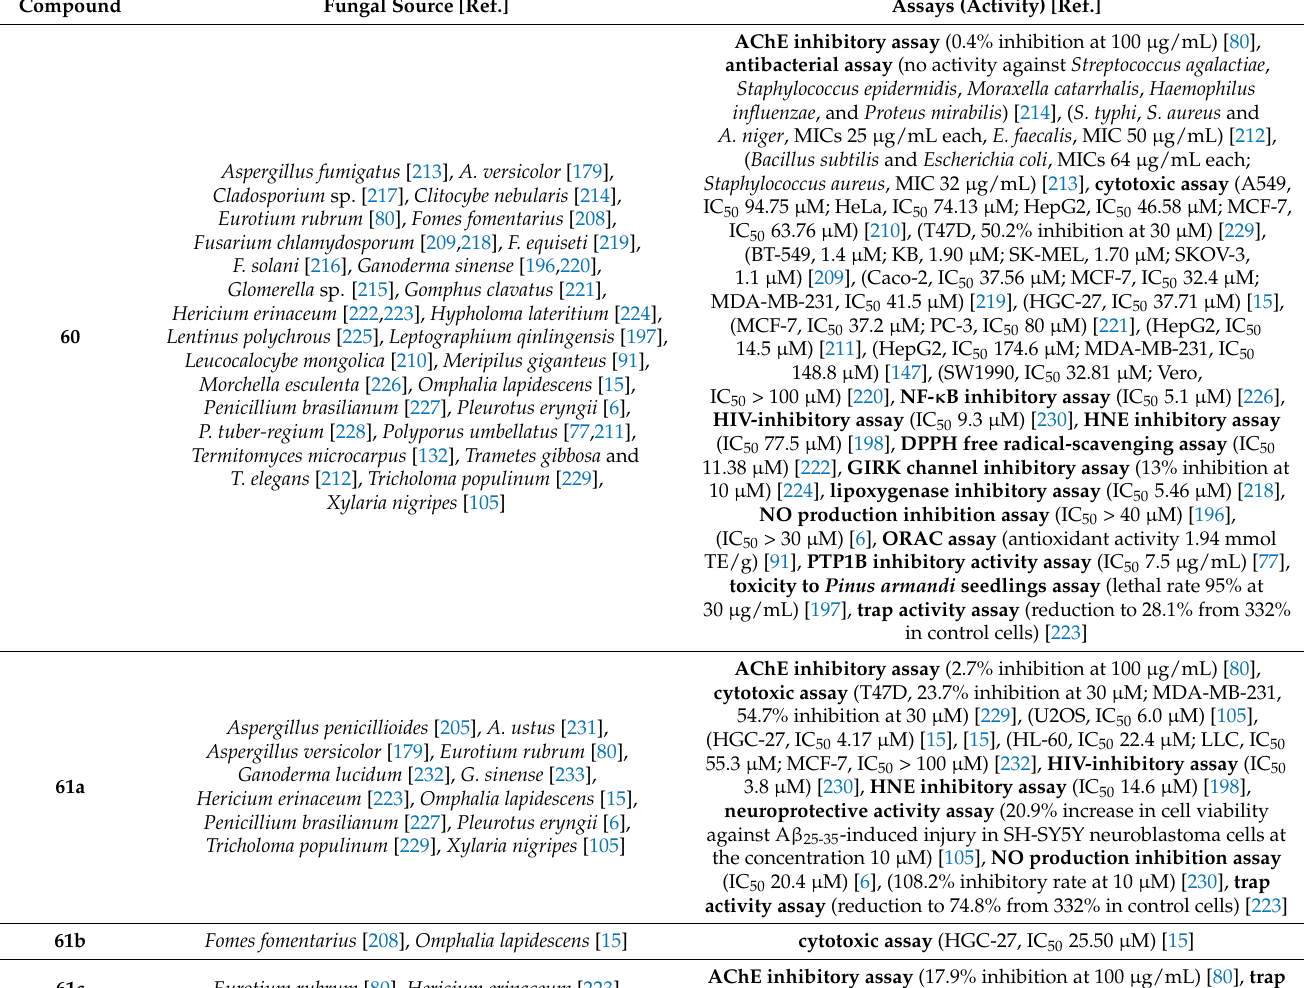
Table 3. Sources and biological activity of fungal alcohols. Compound Fungal Source